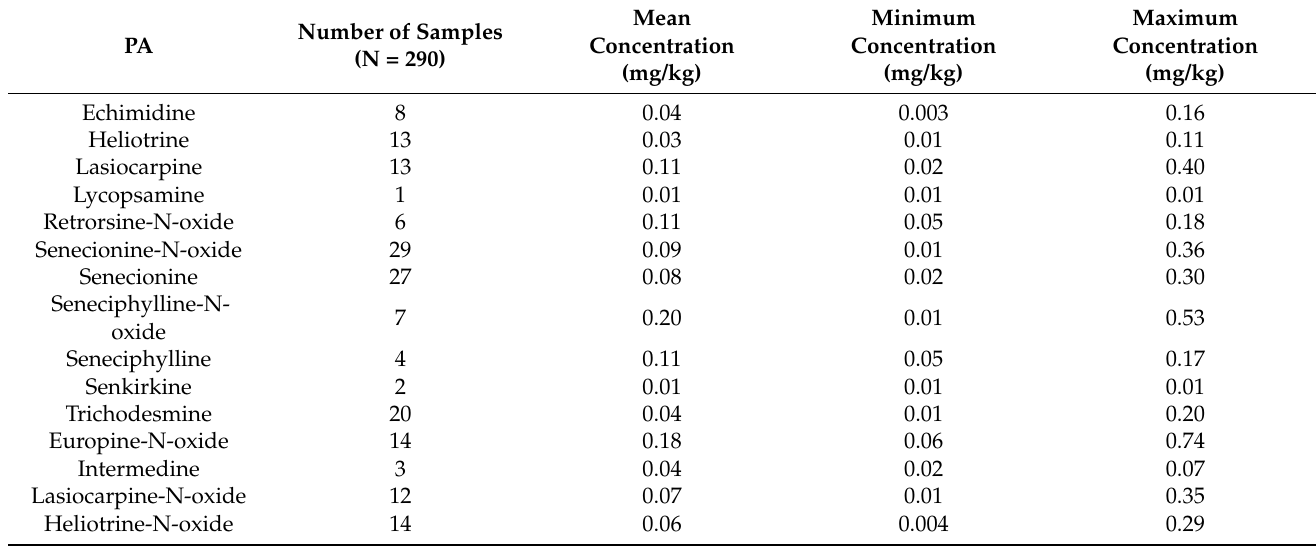
Table 5. Summary of targeted PAs